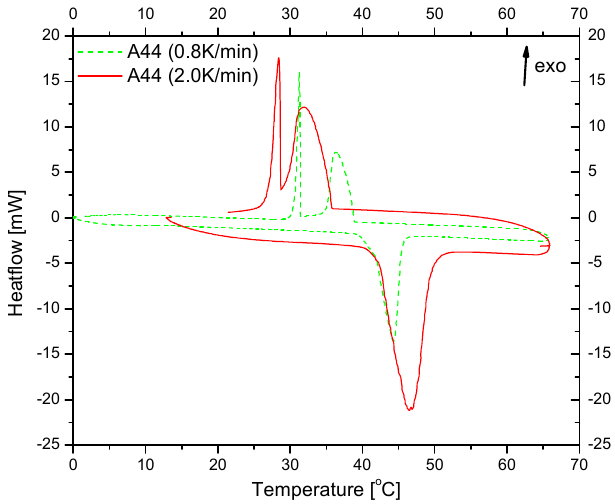
Figure 4. Differential scanning calorimetry (DSC) results of A44 on heating and cooling cycle under 0.8 °C/min and 2.0 °C/min.